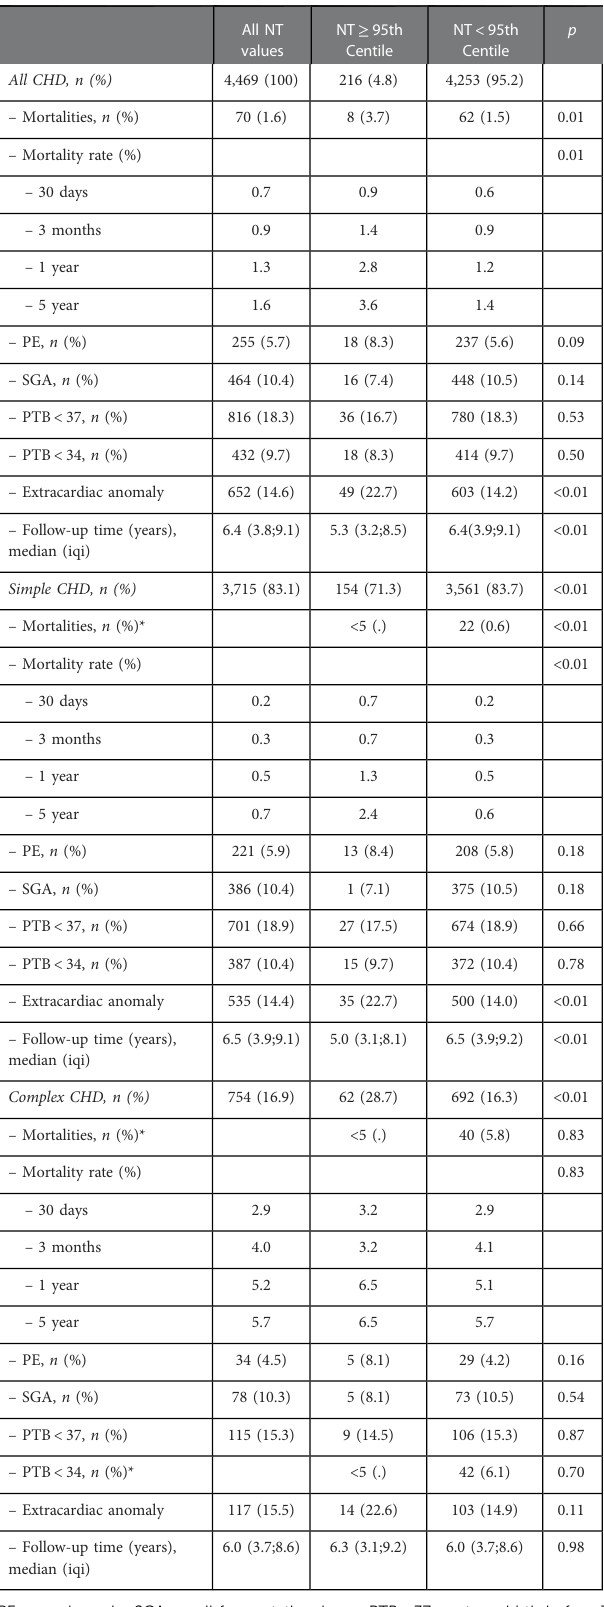
TABLE 3 Mortalities and covariates in subgroups of CHD and NT. All NT